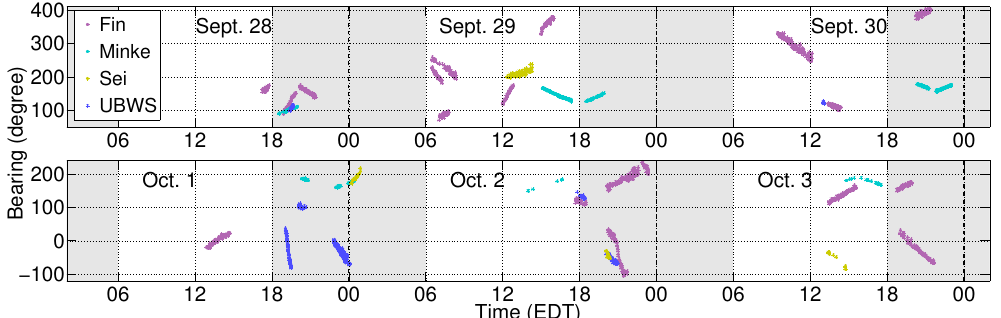
Figure 2. The bearing-time trajectories of four distinct baleen whale species: fin whale, minke whale, sei whale and unidentified baleen whale species. One thousand four hundred and ten fin whale vocalizations, 431 minke whale pulse trains, 125 sei whale vocalizations and 417 unidentified baleen whale species vocalizations were selected to estimate the species-dependent baleen whale vocalization source levels. These vocalizations are a subset of the larger set of baleen and toothed whale vocalizations measured by the POAWRS receiver array for each species (see the Extended Data Figures 1–4 of [1]). The bearings are measured with respect to true